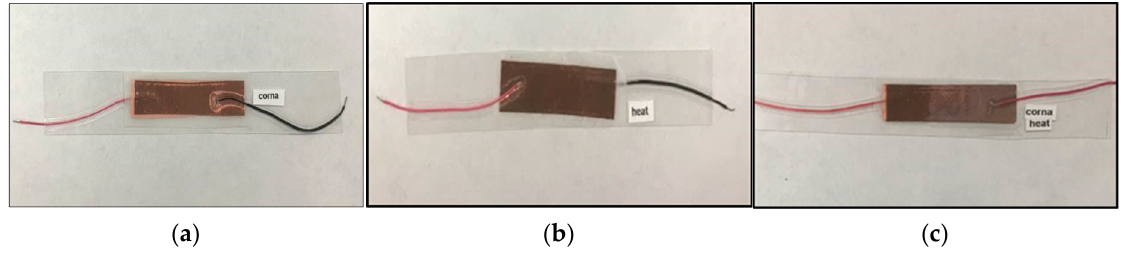
Figure 3. Pristine PVDF membrane sensors: ( a ) Corona treated, ( b ) Heat treated, ( c ) Heat + Corona treated .